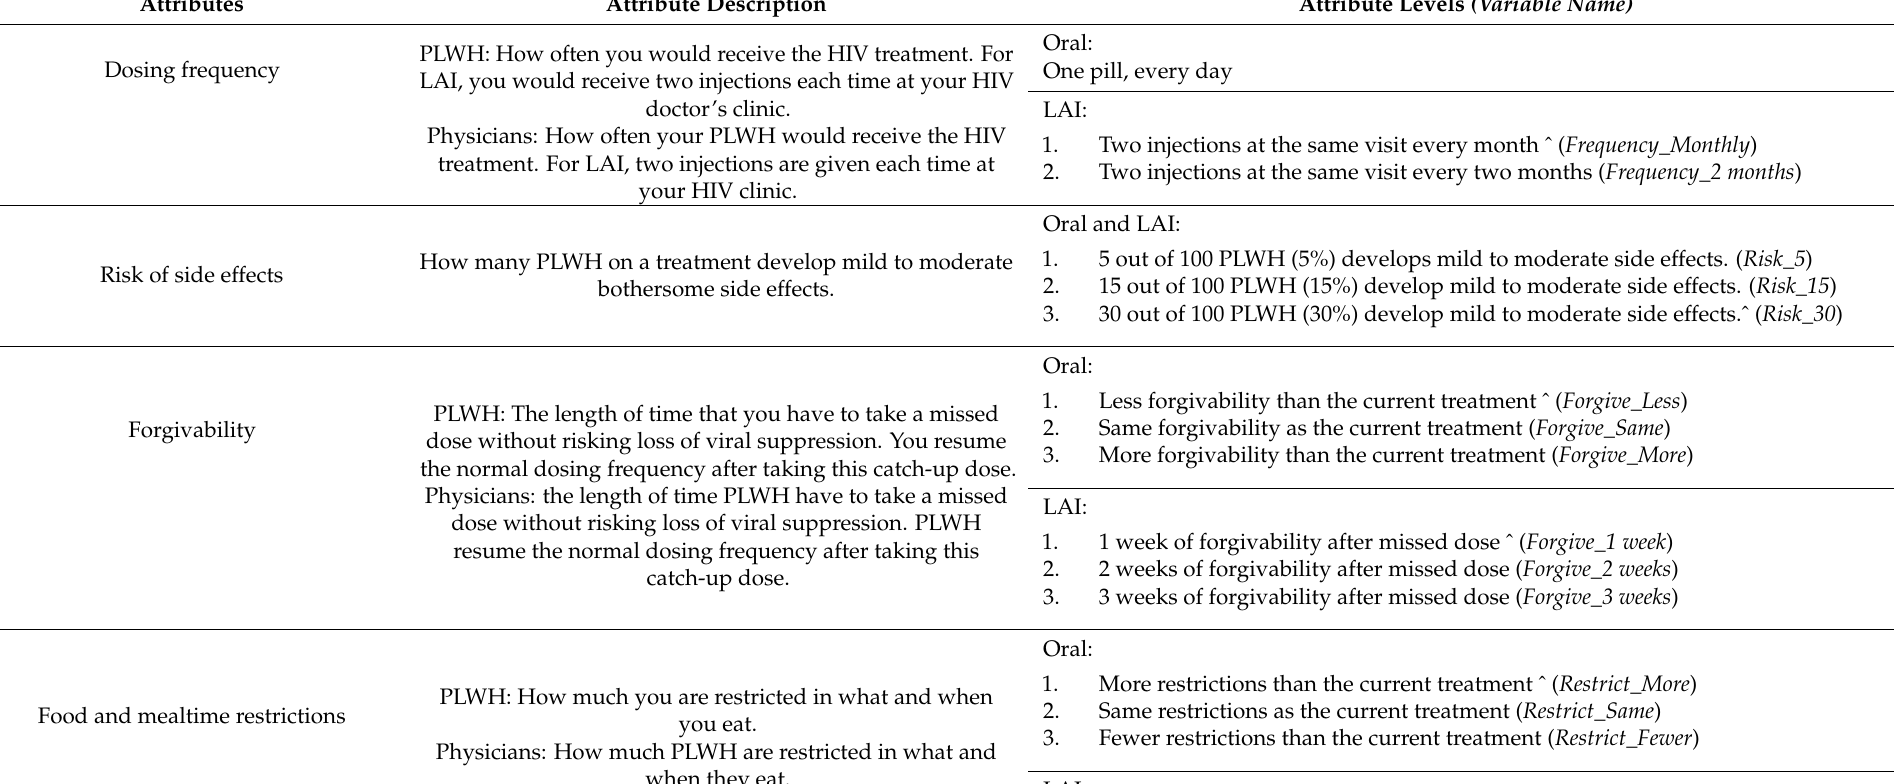
Table 1. DCE Attributes and